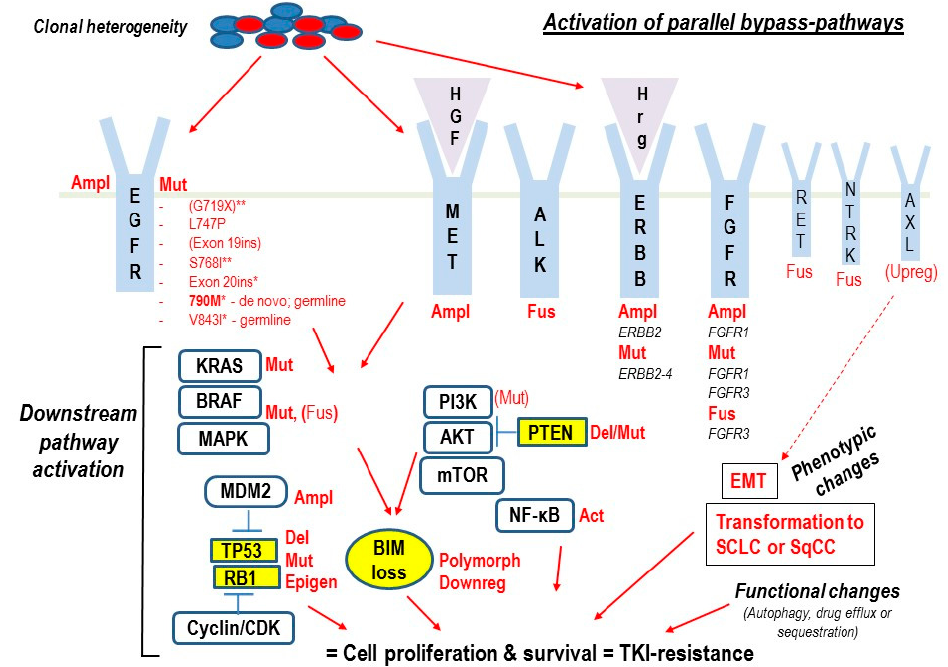
Figure 1. Summary of main molecular mechanisms of intrinsic resistance to EGFR-tyrosine-kinase-inhibitors (EGFR-TKIs) in EGFR -mutated ( EGFR M + ) non-small cell lung cancer (NSCLC). Given the clonal genetic heterogeneity of NSCLC, innate genetic alterations capable of impairing the response and causing intrinsic resistance to TKIs may be present in pre-existing clones before treatment (de novo alterations) or may be very rapidly induced in surviving cancer cells as immediate adaptive response or tolerance to the targeted therapy. If the relative allelic frequency of one or several (polyclonal resistance) of these pre-existing / immediately induced alterations is su ffi cient to very rapidly counteract the e ff ect of TKIs (conventionally within the first 3 months after TKI-treatment initiation), tumor cells will continue to proliferate and survive, and intrinsic TKI-resistance will ensue. The EGFR-dependent resistance mechanisms are represented by amplification ( Ampl ) and / or specific somatic or germline mutations ( Mut ) of the EGFR -gene. Some of these mutations cause resistance to EGFR-TKIs of all three generations, while others are sensitive to 2G or 3G TKIs, as indicated (* = EGFR-mutants resistant to 1G / 2G EGFR-TKIs, but sensitive to 3G TKIs, the most common being T790M indicated in bold; ** = EGFR-mutants resistant to 1G EGFR-TKIs, but sensitive to afatinib). Among the uncommon EGFR -mutations G719X and insertions in exon 19 (Exon 19ins) are indicated in brackets, because despite being less sensitive than common EGFR-mutants, they may show some response to 1G TKIs. Instead, most of the EGFR-independent resistance mechanisms are shared by EGFR-TKIs of all three generations and include the activation of by-pass pathways via amplification ( Ampl ), mutation ( Mut ) or fusion ( Fus ) of alternative parallel receptor tyrosine kinase- (RTK)-genes such as Mesenchymal-Epithelial Transition ( MET), Anaplastic Lymphoma Kinase (ALK) , non-EGFR Erythroblastic Oncogene B ( ERBB) -family-members, Fibroblast Growth Factor Receptor genes ( FGFR s) (written in bold), and possibly REarranged during Transfection ( RET ) and Neurotrophic Tyrosine Receptor Kinase (NTRK) (not in bold). Activation of parallel RTKs can also be induced by overexpression of hepatocyte growth factor (HGF) that binds the MET-receptor or Heregulin (Hrg) that binds ERBB2. Alternative downstream by-pass mechanisms of resistance are represented by mutations, fusions, or deletion ( Del ) of members of the RAS-RAF-MEK-MAPK and PI3K-AKT-PTEN-mTOR pathways or inactivation of TP53 and / or retinoblastoma 1 (RB1) tumor-suppressor genes via mutation / deletion / epigenetic mechanism ( Epigen ) or indirectly by gene-amplification of the p53-inhibitor Mouse Double Minute 2 homolog (MDM2) and mutation / amplification of genes encoding cyclins and cyclin-dependent kinases (CDKs). Additional by-pass mechanisms are activation ( Act ) of the NF- κ B transcription factor by di ff erent pathways